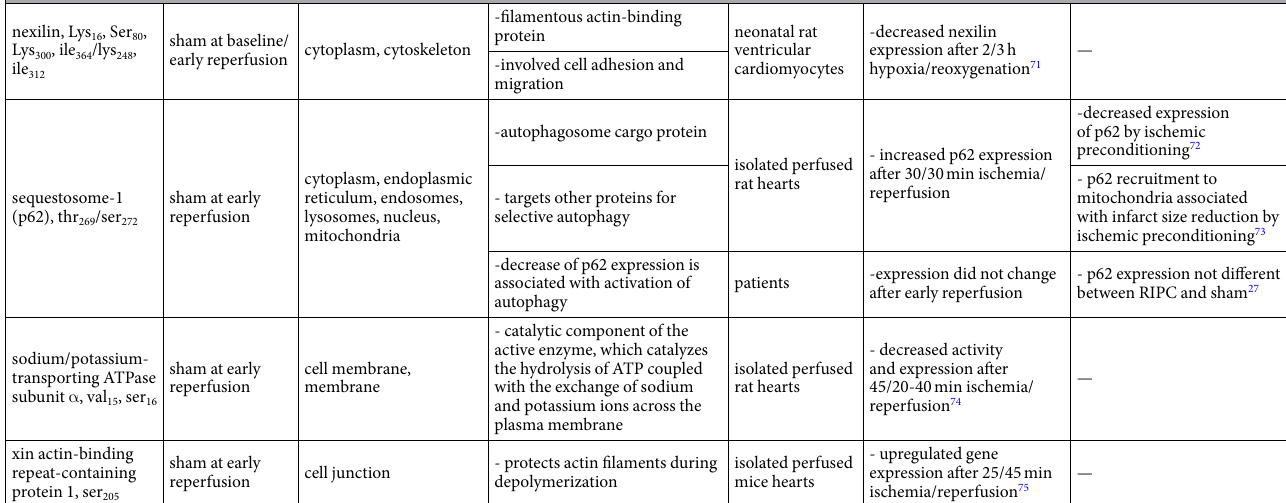
Among the identified proteins, 11 proteins have already been described in relation to myocardial ischemia/ reperfusion and/or cardioprotection. These prior studies analyzed almost exclusively the expression and not the phosphorylation of these candidate proteins; therefore, nothing is known yet about the role of the here identified phosphorylation sites. These proteins may, however, be potential novel candidates as cardioprotective signals induced by RIPC than with sham (Table 3), and it may be worthwhile to analyze them further. Independent of the FDR-based statistical analysis, the phosphoproteome analysis of porcine LV biopsies revealed a shift towards a greater number of proteins with increased phosphorylation at early reperfusion with RIPC than with sham (Fig. 6b and c). Such shift was not seen after phosphoproteome analysis of human LV biopsies. Almost all identified proteins with a different expression/activation at early reperfusion were different between humans and pigs, reflecting and confirming the established species-specific differences. However, without dif- ferentiation between expression and phosphorylation of all detected proteins, the Ingenuity knowledge base identified mitochondria and cytoskeleton in association with RIPC at early reperfusion in both species. These associations may or may not relate to their causal involvement in cardioprotection by ischemic conditioning strategies (Fig. 8). Mitochondria are well established end-effectors of cardioprotective strategies, and the preservation of mito- chondrial function after ischemia/reperfusion is decisive for the survival of cardiomyocytes and thus salvage of myocardium 22, 39 . RIPC preserved mitochondrial respiration after ischemic cardioplegic arrest compared to sham in right atrial appendages of patients undergoing CABG 40, 41 . The plasma transfer from pigs, which had under- gone RIPC, to isolated perfused rat hearts reduced infarct size and improved mitochondrial function at early reperfusion after global ischemia 42 . The protection by simulated ischemic preconditioning was associated with attenuated osmotic fragility through cytochalasin D–sensitive stabilization of the actin cytoskeleton in isolated rabbit cardiomyocytes after simulated ischemia for 3 h 43 . Also, the phosphorylation of sarcomeric Z-disc associated proteins was increased immediately after the RIPC procedure compared to that after sham procedure in mice hearts 44 . Pharmacological interventions induced long-term expression changes of proteins related to cytoskeletal regulation in pig hearts 45 . There are several limitations to our current analysis: 1) We analyzed biopsies from only a small cohort of patients with an uneven distribution of co-morbidities and co-medications (Table 1), which both, potentially interfere with ischemic conditioning maneuvers 29, 34 . To overcome this issue and to increase the power of a pro- teome analysis, the inclusion of more patients with a more balanced set of co-morbidities and co-medications would be required. 2) The size of human and porcine biopsies was small and precluded a parallel extraction of proteins from one sample with different lysis and digestion methods. A small sample size may result in a sampling error and a high variability of its cellular composition. 3) Given the small sample size, we analyzed total myocar- dial proteins and did not distinguish between different cellular and subcellular compartments. Proteome analysis targeting different, isolated cellular and subcellular compartments may decipher more complex, multivalent sig- nals 37 . 4) We analyzed only one posttranslational protein modification, i.e. protein phosphorylation. Although cardioprotective proteins are mainly regulated by phosphorylation 33 , we cannot exclude differences by RIPC in other posttranslational modifications. Sufficient tissue sampling for additional analysis of acetylation, O-linked β -N-acetylglucosaminylation, S-nitrosylation, etc. was not possible. 5) Although we identified 116 proteins with a difference in phosphorylation mainly between baseline and early reperfusion in pigs with RIPC and/or with sham, only 3 antibodies were commercially available against proteins with the identified phosphorylation sites to verify the phosphoproteome data by Western blot analysis. 6) We analyzed human LV biopsies at only one